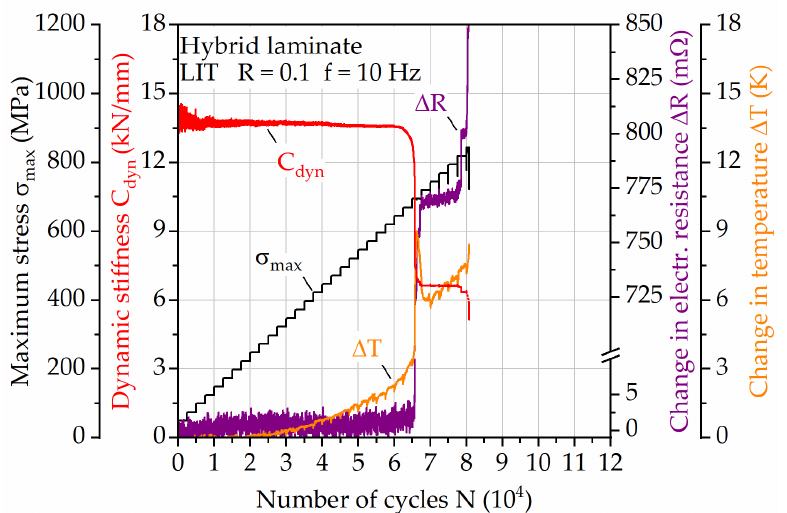
Figure 7. Load increase test for hybrid laminate in 1/2-configuration of 1.4310 and carbon fiber reinforced PA 6; development of dynamic stiffness, change in temperature and electrical resistance when testing with constant frequency.